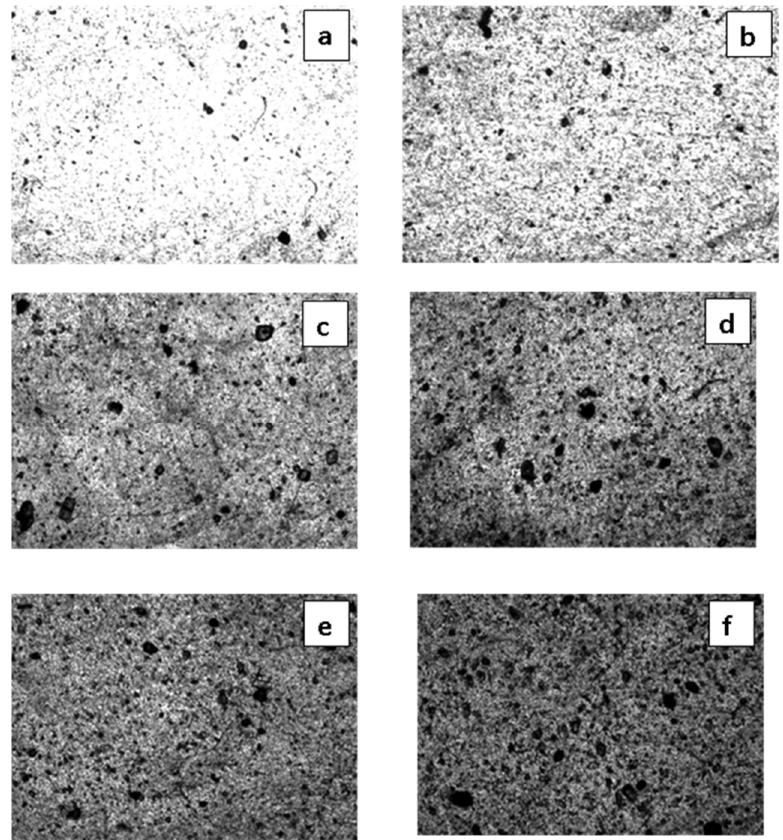
Figure 3. Antirio-posterior photographs of UV-cured samples at ( a ) 0.2, ( b ) 0.4, ( c ) 0.6, ( d ) 0.8 ( e ) 1.0 and ( f ) 1.5 phr of the antioxidant (magnified but not quantified). The elongation at break also showed a decreasing trend as a function of the photoin- itiator concentration as is evident from Figure 4.